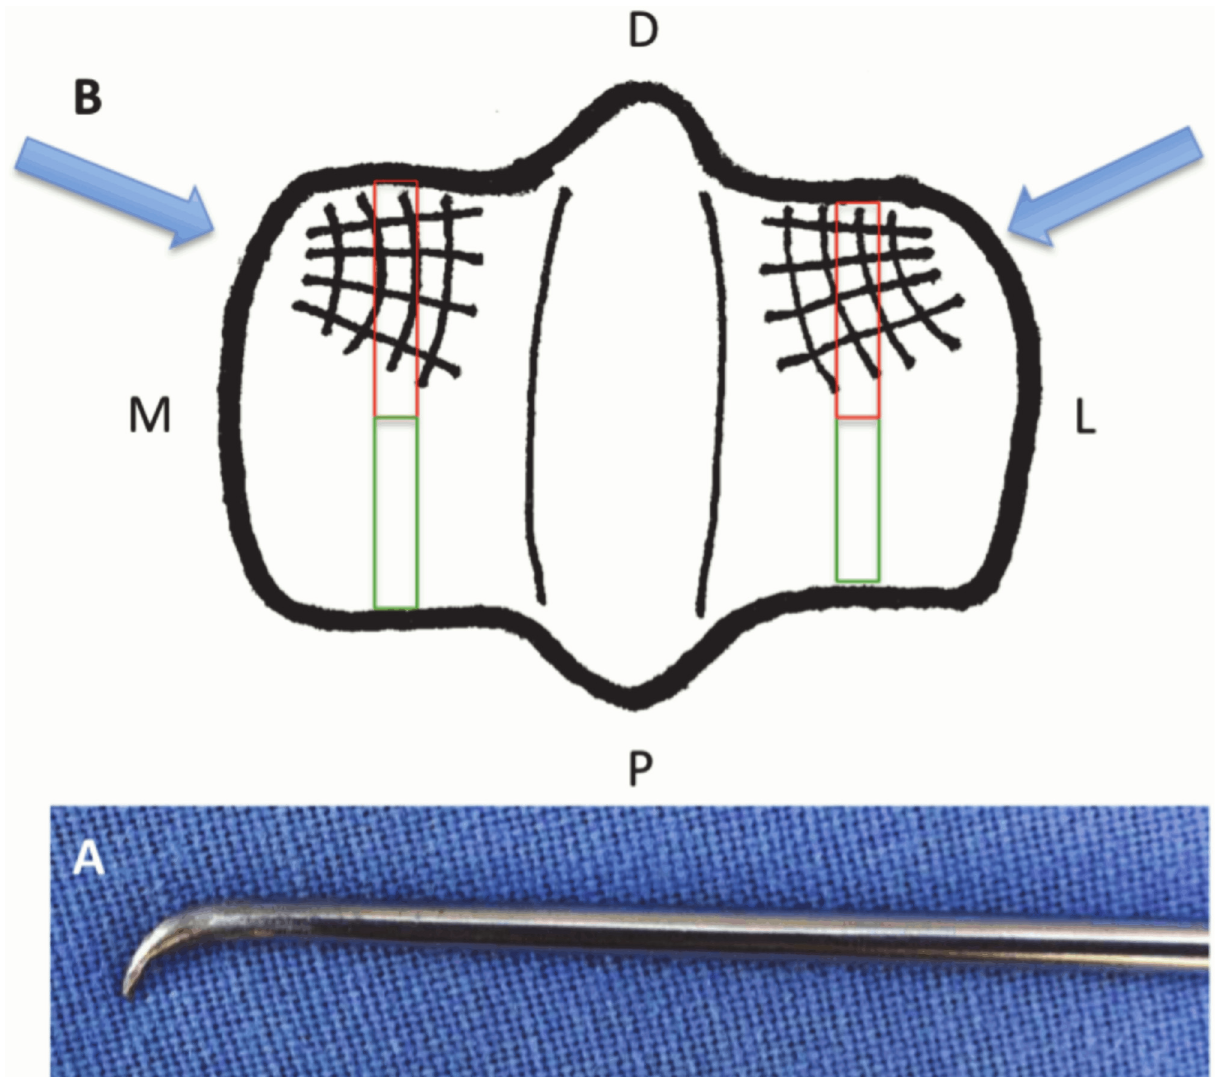
Figure 1. (A) Modified arthroscopic probe in which the tip was hooked and sharpened to a 2 mm internal length. (B) The distal MC3: D = dorsal, P = palmar, L = lateral, and M = medial. A woven pattern of 4 dorso-palmar and 4 radial grooves created on the weight-bearing area of the lateral and medial condyles. Blue arrows represent the direction the instrument was introduced. Red and green rectangles represent the dorsal histologic slices centered over the groove areas and the palmar histologic slices in the continuity of the dorsal slices.